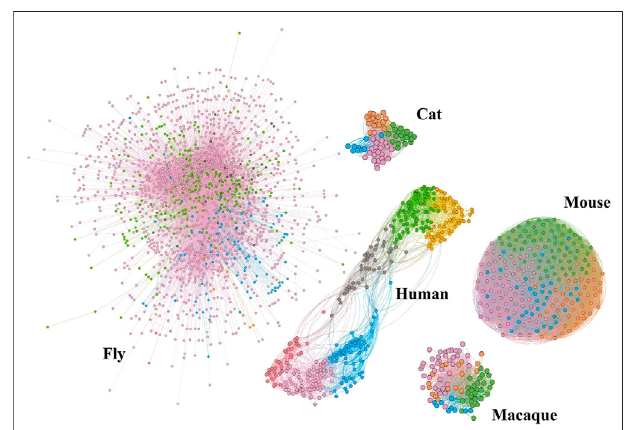
FIGURE 1 | Community topology of brain structural networks for different species, including cat, fl y, human, mouse, and macaque. Among them, the networks of cat, fl y, mouse, and macaque are from the Network Repository [28]